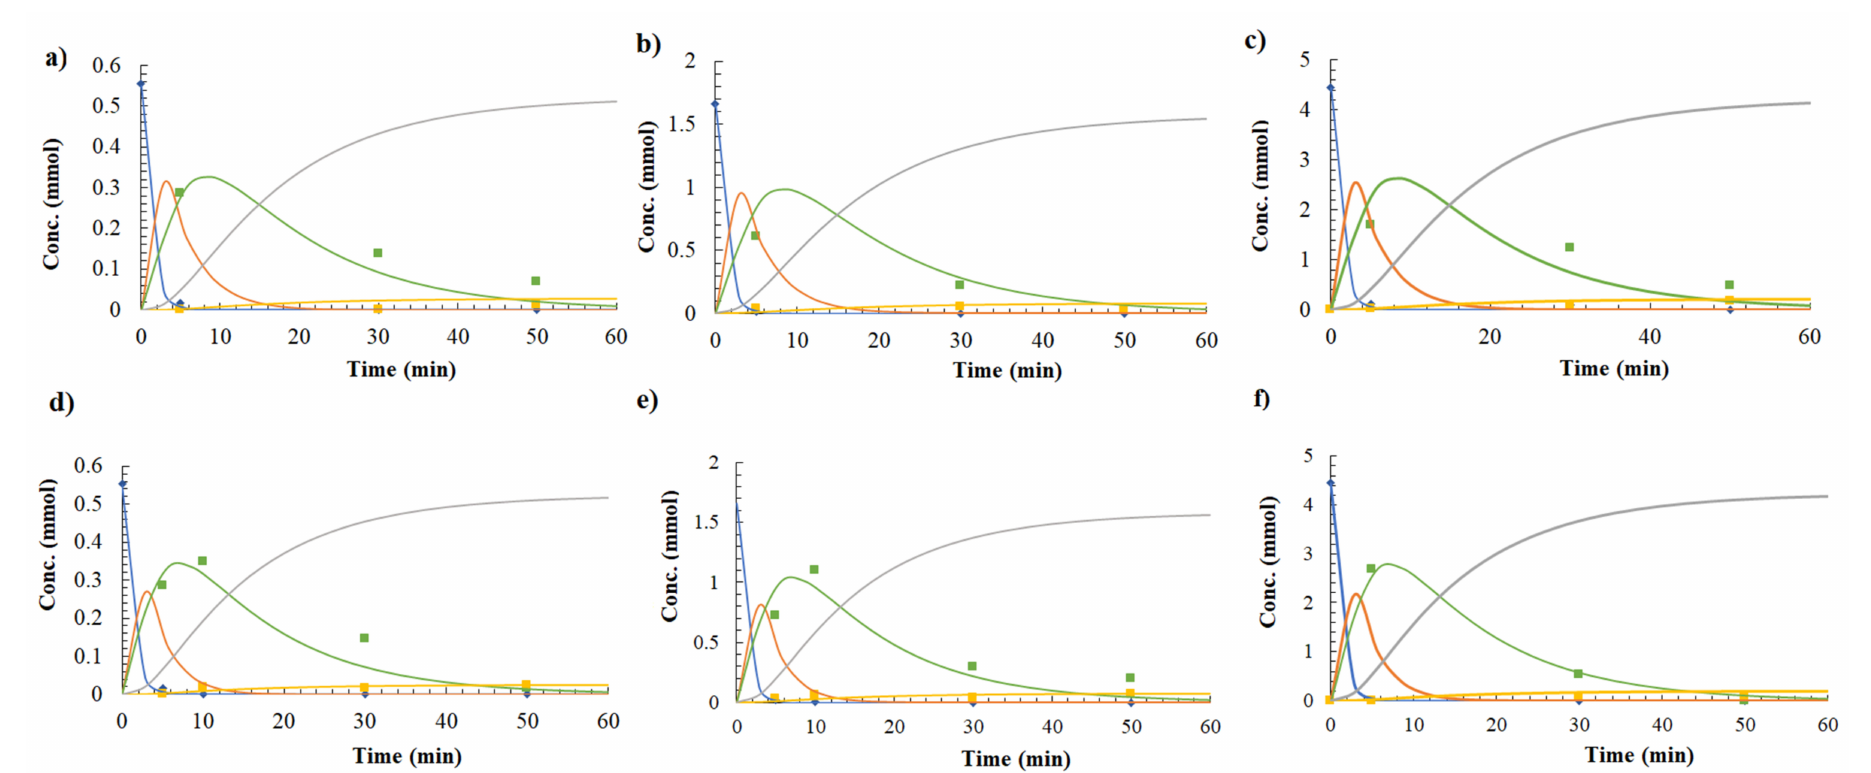
Figure 4. Performance profile of the products of acid-catalyzed fructose dehydration at ( a – c ) 140 ◦ C and ( d – f ) 150 ◦ C for 100, 300, and 800 mg under MW conditions with 3 mL solvent, 10 mg MIL-101(Cr)-SO 3 H(3), and 100 mg fructose (0.56 mmol). Symbols denote experimental values: ( (cid:4) , — ) fructose conversion, ( — ) intermediate formation, ( (cid:4) , — ) 5-HMF production, ( (cid:4) , — ) LA + FA production, ( — ) side product